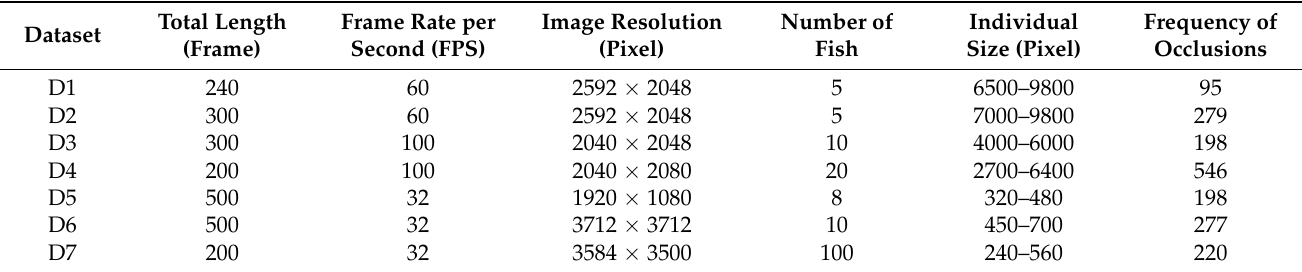
Table 1. Description of experimental